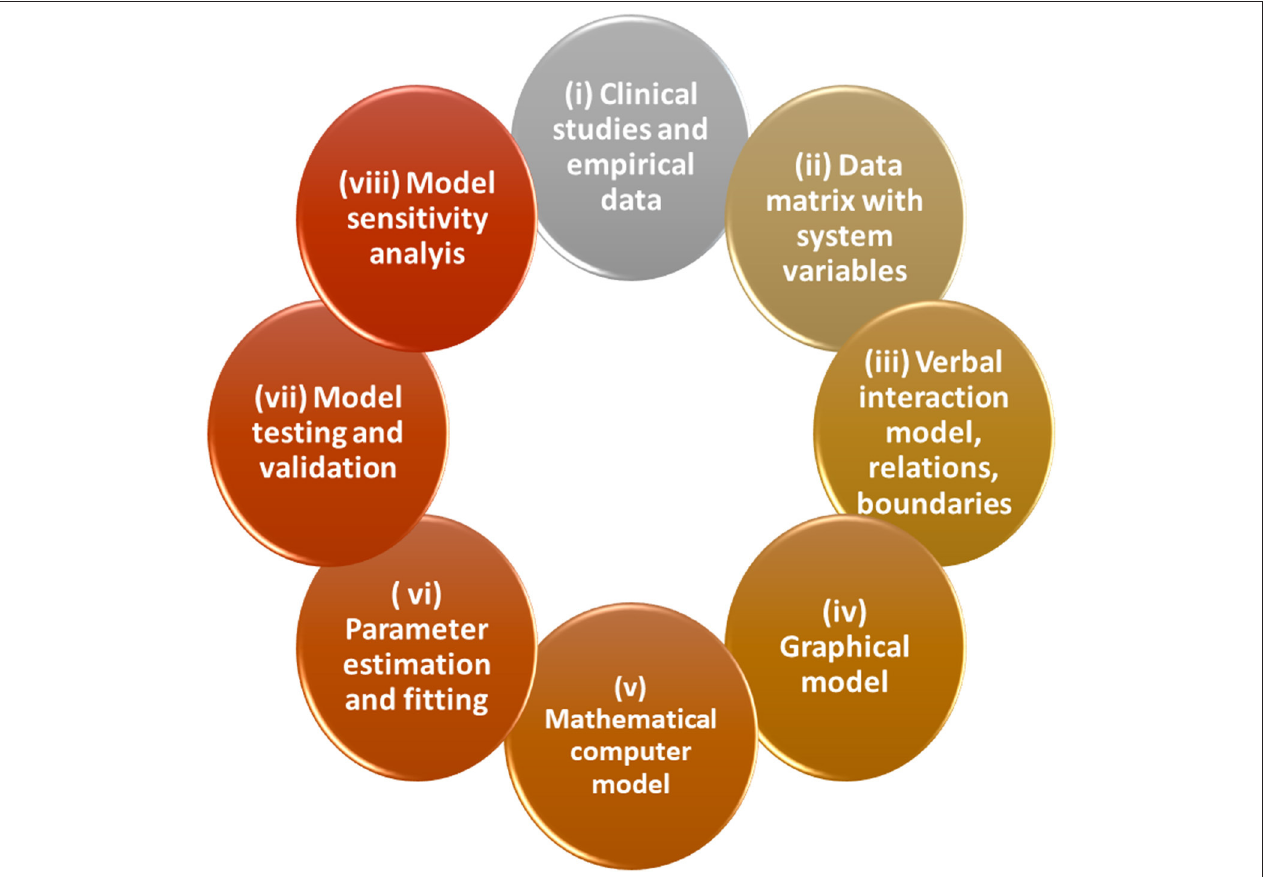
FIGURE 2 | Methodology for iterative optimization of exploratory and quantitative models in Systems Medicine. In the following the workflow is described: (i) data collection, observations in a “transdisciplinary” groups, (ii) generation of data matrices, (iii) drafting a verbal model of interactions of components, definition of the system, elements, relations, and boundaries necessary for the subsequent formal models (iv) construct graphical model of causal loops and/or of stocks and flows/effects (decide about graphical language), (v) drafting mathematical equations, (vi) parameter estimation and fitting using existing data, state and flow variables, and coefficients (if not possible: “educated guess” by expert-based estimations), (vii) transposition to computational model simulation, model tests, validation, scenarios: “…if, then…,” (viii) model prediction and extrapolation and comparison with data, further validation and model optimization with backward improvements (for further details see